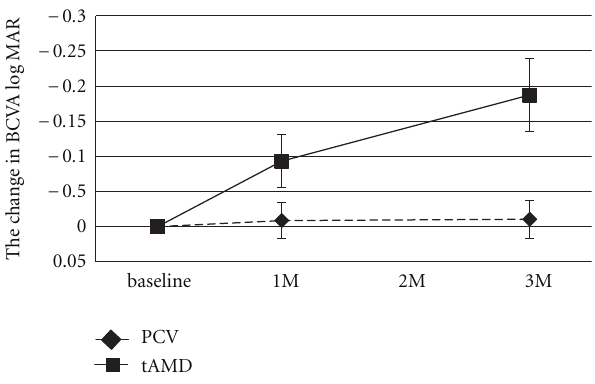
Figure 1: Changes in the best-corrected visual acuity (BCVA) for tAMD and PCV patients after intravitreal ranibizumab. The BCVA was determined using the Landolt C chart and was presented as decimal visualacuities. Diamondswithdashed lines:tAMD; squares with solid lines: PCV. Values represent means ±